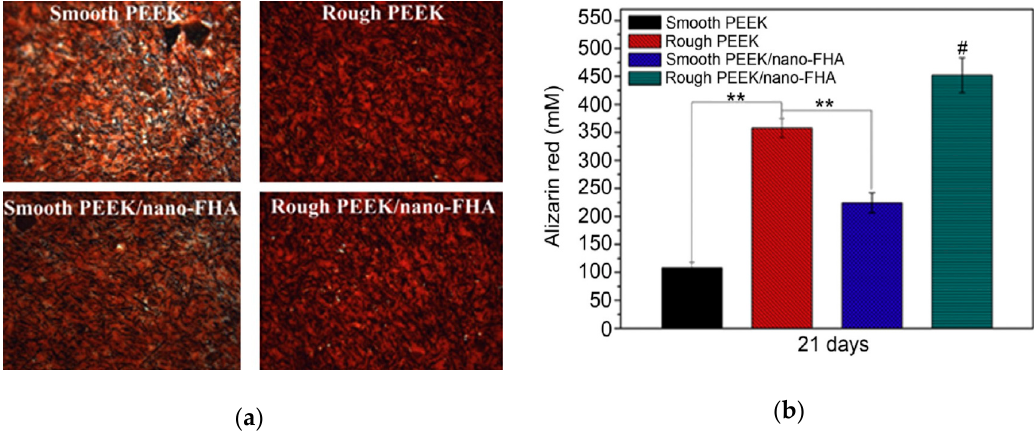
Figure 19. ( a ) The formation of mineralized extracellular matrix of hMSCs cultivated on different PEEK-based samples after staining with Alizarin Red S at day 21. Alizarin red dye stained the cells containing calcium deposits in dark red color. ( b ) Mineralization of hMSCs seeded on both smooth and rough PEEK as well as its composite groups at day 21 using Alizarin Red S assay. ** represents p < 0.01, and # represents p < 0.05 compared with other groups. Reproduced from [164] with permission of Elsevier.